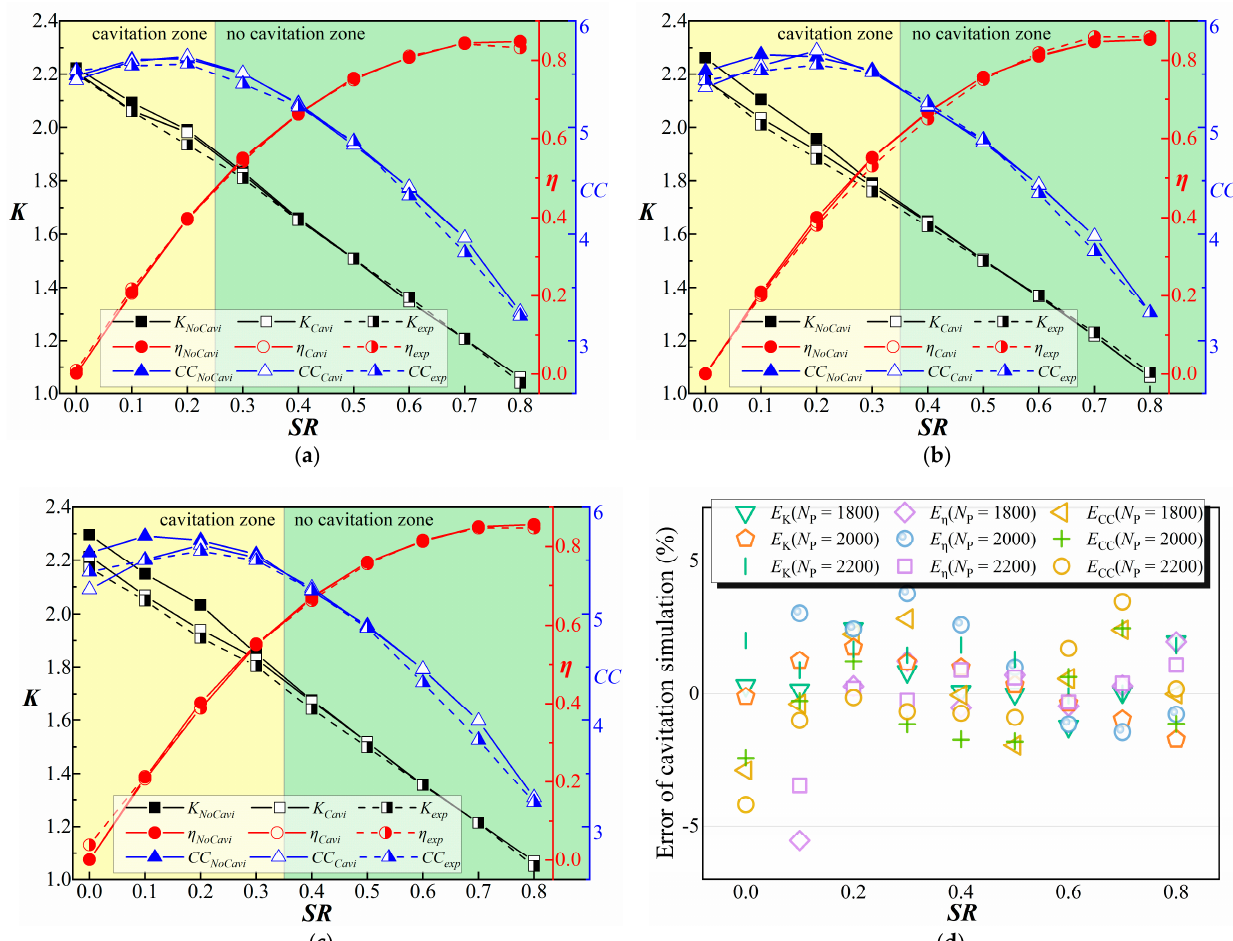
Figure 5. Comparison of torque ratio, efficiency, and capacity constant between no cavitation, cavitation, and test under various N P and SR. ( a ) N P = 1800 rpm. ( b ) N P = 2000 rpm. ( c ) N P = 2200 rpm. ( d ) Error of the cavitation simulation.